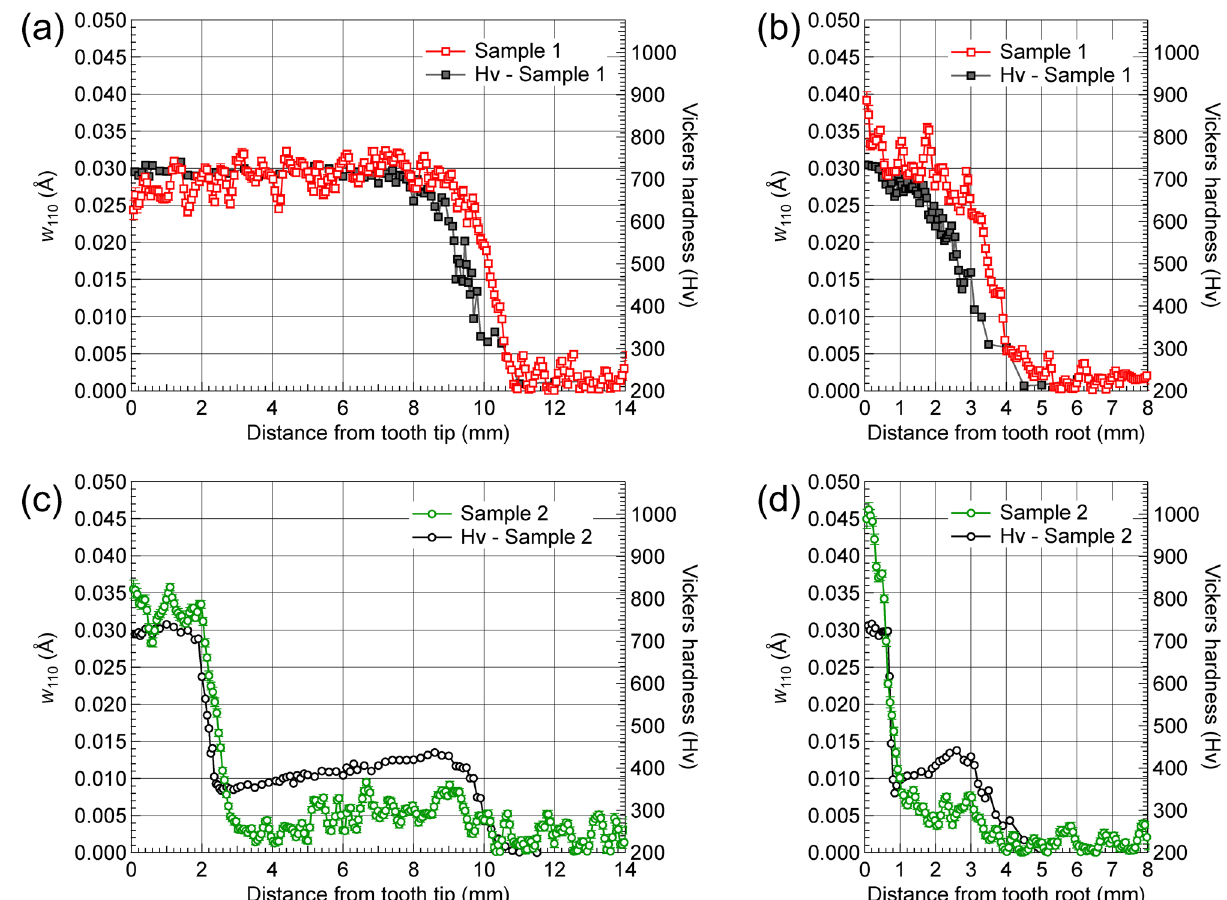
Figure 10. Changes in micro-Vickers hardness and the Bragg-edge broadening of the 110-crystal lattice plane spacing, w 110 , plotted against distance from the tooth tip of each gear ( a , c ) and tooth root ( b , d ), as indicated by the arrows in Fig.